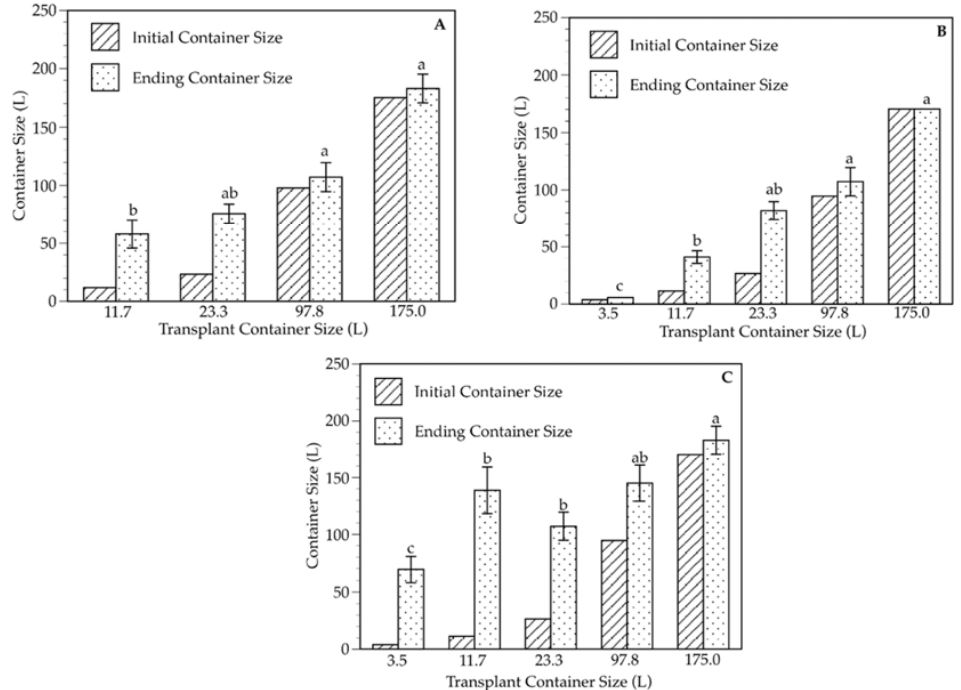
Figure 4. Mean ( ± standard error) of initial and ending container size of Acer rubrum ( A ); Taxodium distichum ( B ); or Vitex agnus ‐ castus ( C ) trees from transplant (diagonal hatching) to the end of the second growing season (stippled hatching). Initial sizes were 3.6, 11.7, 23.3, 97.8 and 175.0 L; n = 6 or T. distichum and V. agnus ‐ castus and 11.7, 23.3, 97.8 and 175.0 L; n = 6 for A. rubrum . Means of ending container sizes with the same letter are not significantly different at p ≤ 0.05 using Student’s t ‐ test. The greatest container size changes for A. rubrum occurred with the 11.7 L and 23.3 L trees which